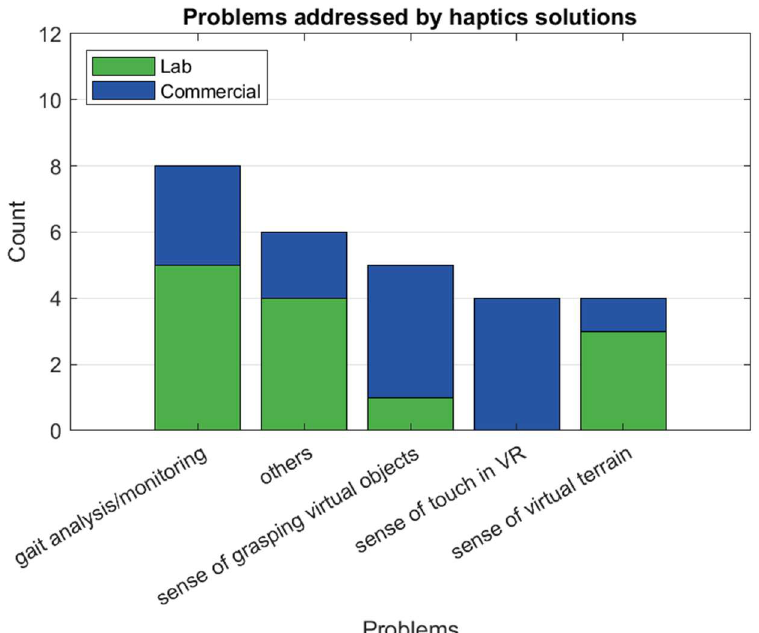
Figure 2. Problems addressed by haptic solutions.